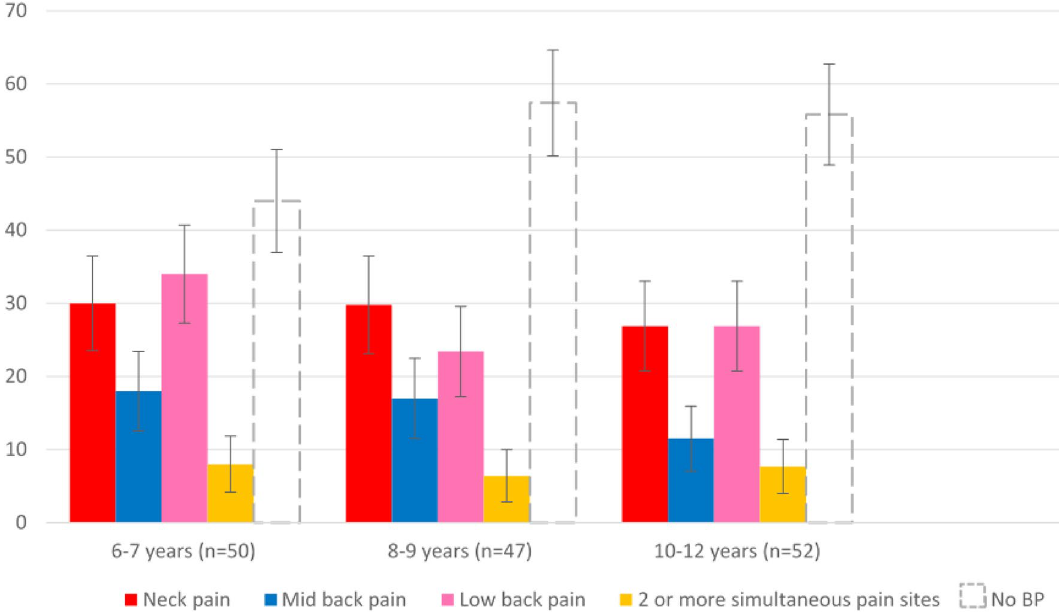
Figure 4. Proportions (standard error) of children with and without BP during the SMS survey as a function of age and pain location(s).